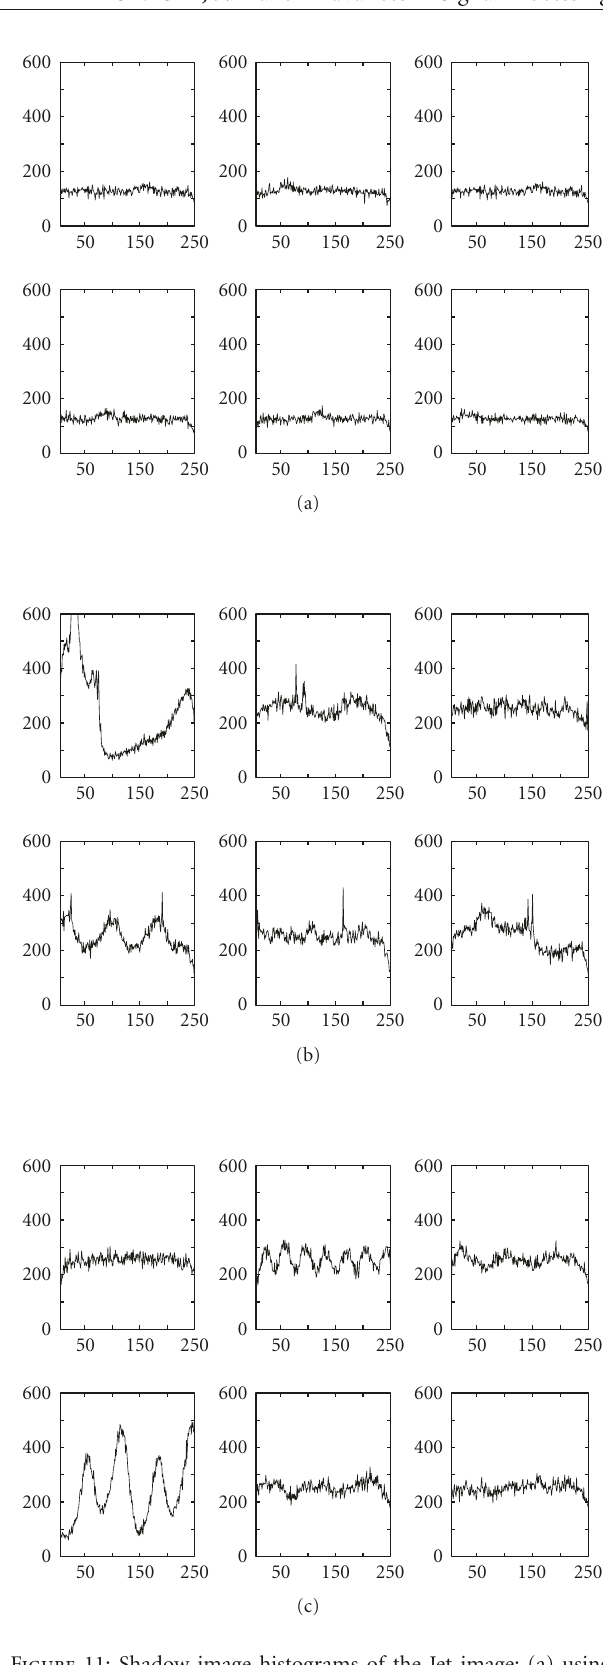
Figure 11: Shadow image histograms of the Jet image: (a) using the proposed method, (b) using TL’s method, and (c) using CL’s method of case